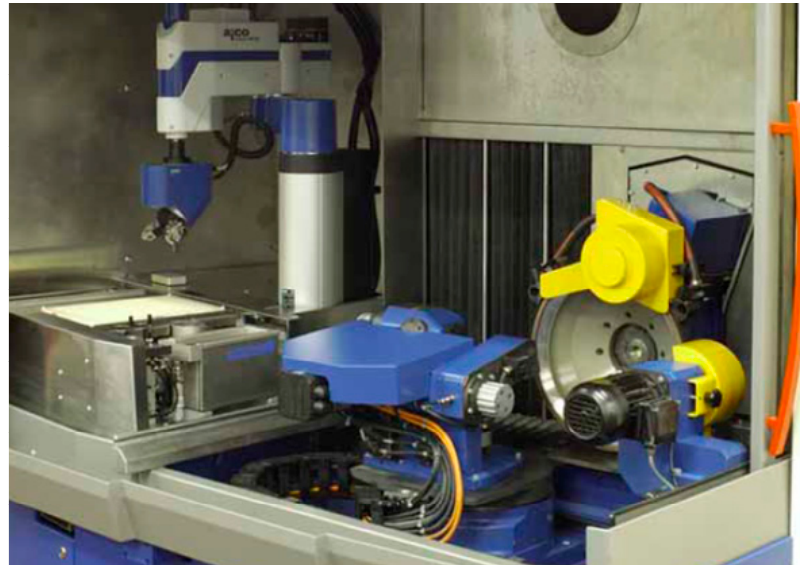
Figure 7. Agathon 400combi grinding machine tool.